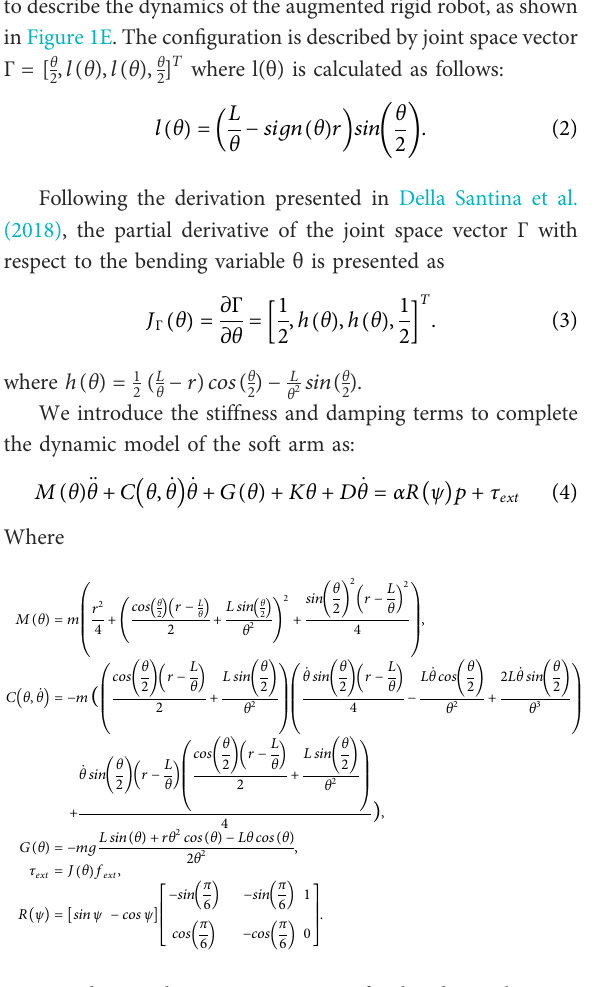
of one edge of the triangle shape is complete. The modulus function ψ mod 2 π /3 is used to draw the other two edges and